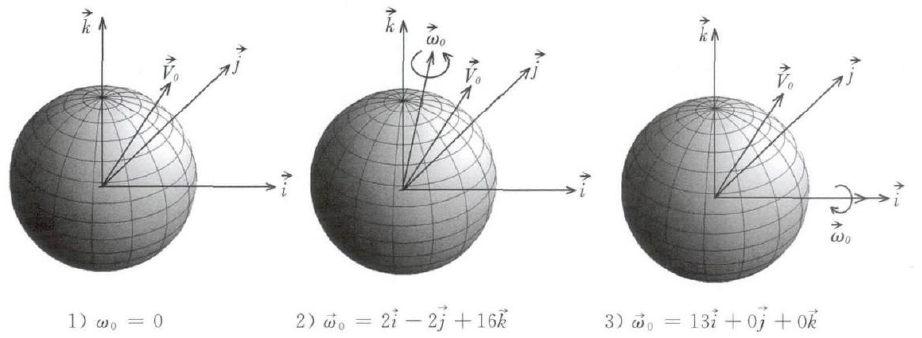
Fig. 1 Schematic diagram of three different initial angular velocities (the take-off velocity is also V 0 ).